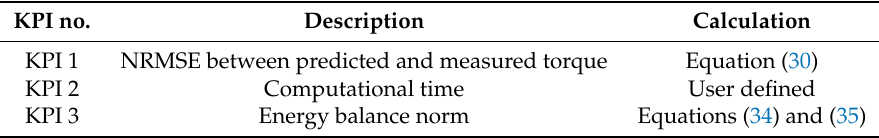
Table 1. Considered Key Performance Indicators (KPIs)